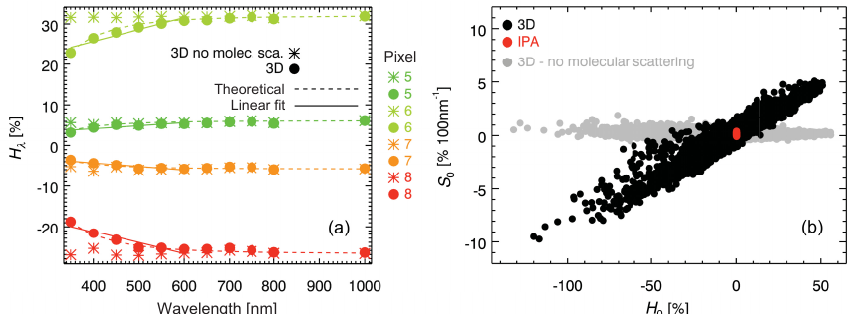
Figure 3. (a) The H λ spectra of pixels {5, 6, 7, 8} from Fig. 1 and Table 1 with ( • ) and without ( ∗ ) molecular scattering in the 3-D calculations, as well as a fit based on Eq. (12) from Sect. 6 (dashed lines) and the simplified linear fit for obtaining S 0 (solid lines). (b) Spectral slope ( S 0 ) vs. net horizontal photon transport ( H 0 ) from (a) (both at 500nm) for all the pixels from Fig. 1. Only 3-D calculations with molecular scattering (black dots) show the systematic correlation between H 0 and S 0 . Disabling molecular scattering (gray dots) incorrectly predicts a spectrally neutral (flat) H λ ( S 0 ≈ 0 for all pixels). By definition, 1-D calculations (IPA, red dots) do not reproduce net horizontal photon transport at all ( H 0 = 0 for all pixels).